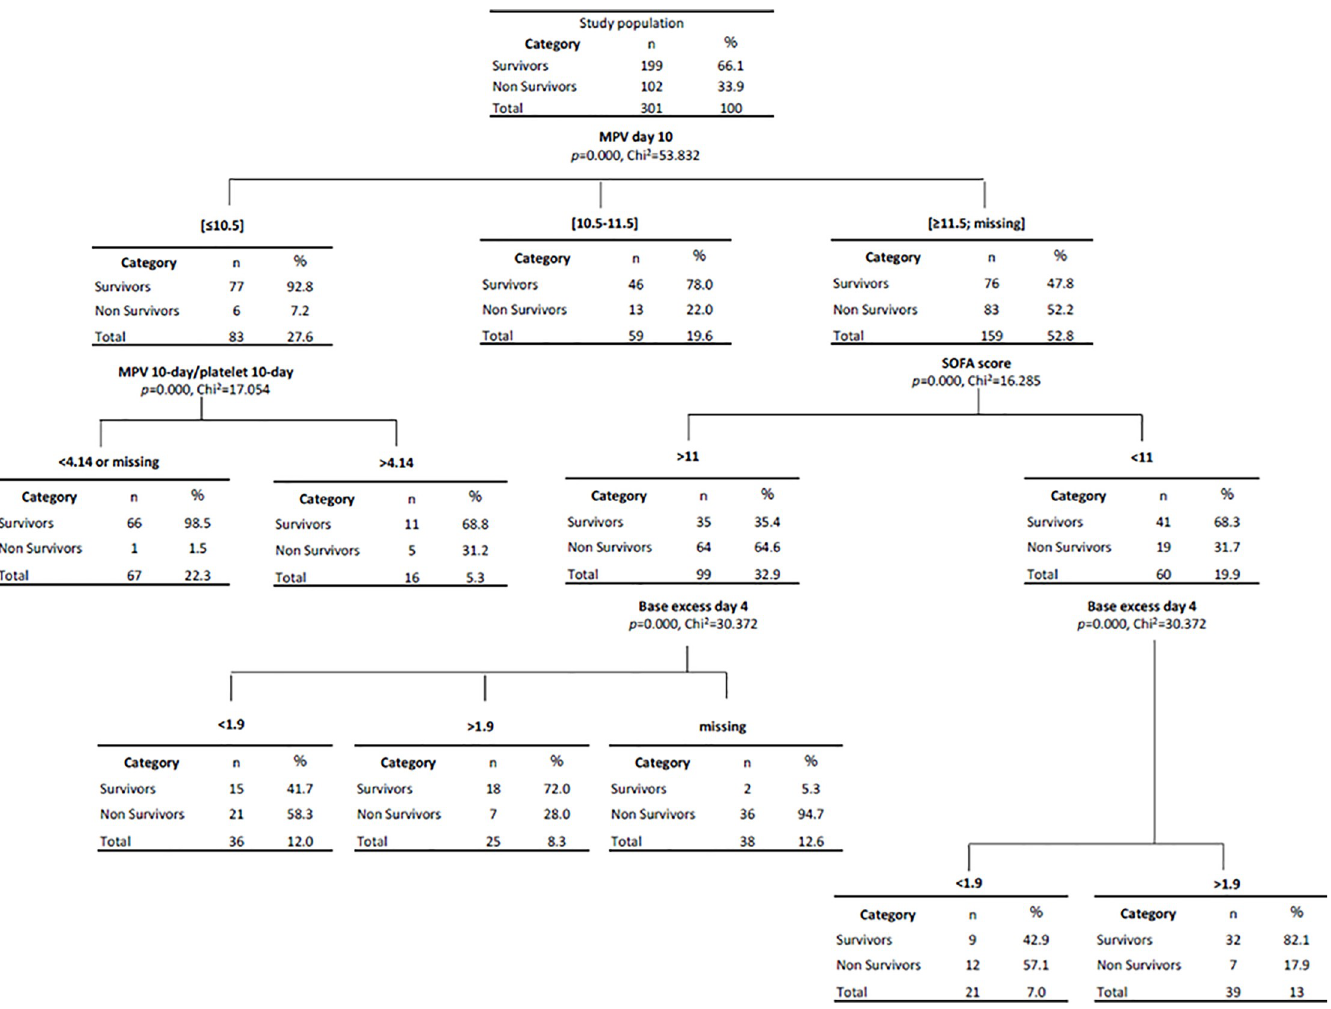
Fig 6. Classification and regression tree (CART) according to 10-day MPV, 10-day MPV/platelet ratio, SOFA score and 4-day base excess.